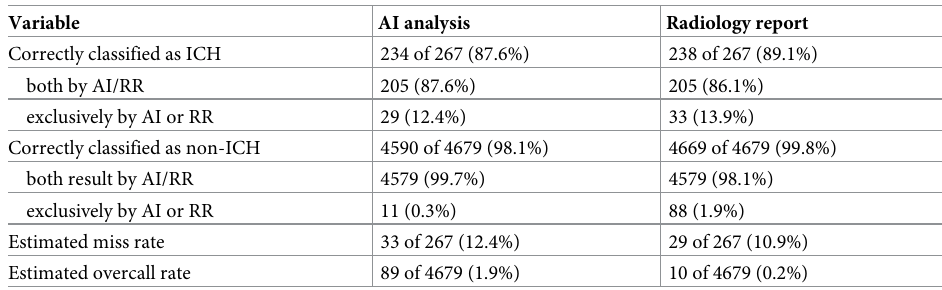
Table 1. Summary of main